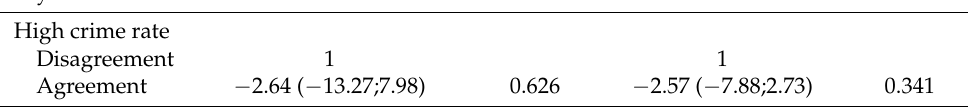
Table 5. Association ( β ; 95%CI) between perceived neighborhood safety and active transportation. Walking Participants Neighborhood ≥ 10 Min/Week * Safety